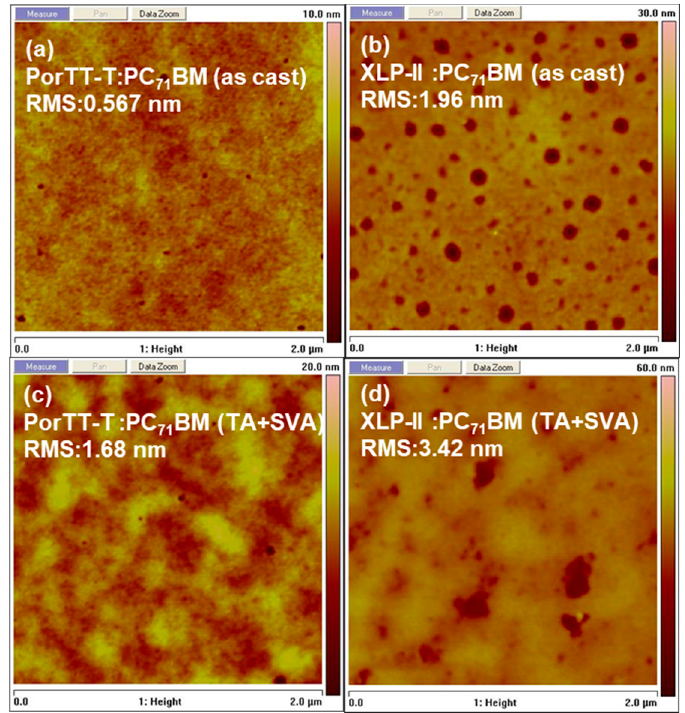
Figure 5. AFM topography images of active layer (D:A) blend films, ( a , b ) as-cast from chlorobenzene, and ( c , d ) after annealing at 100 °C for 10 min with treatment with CF (TA + SVA).